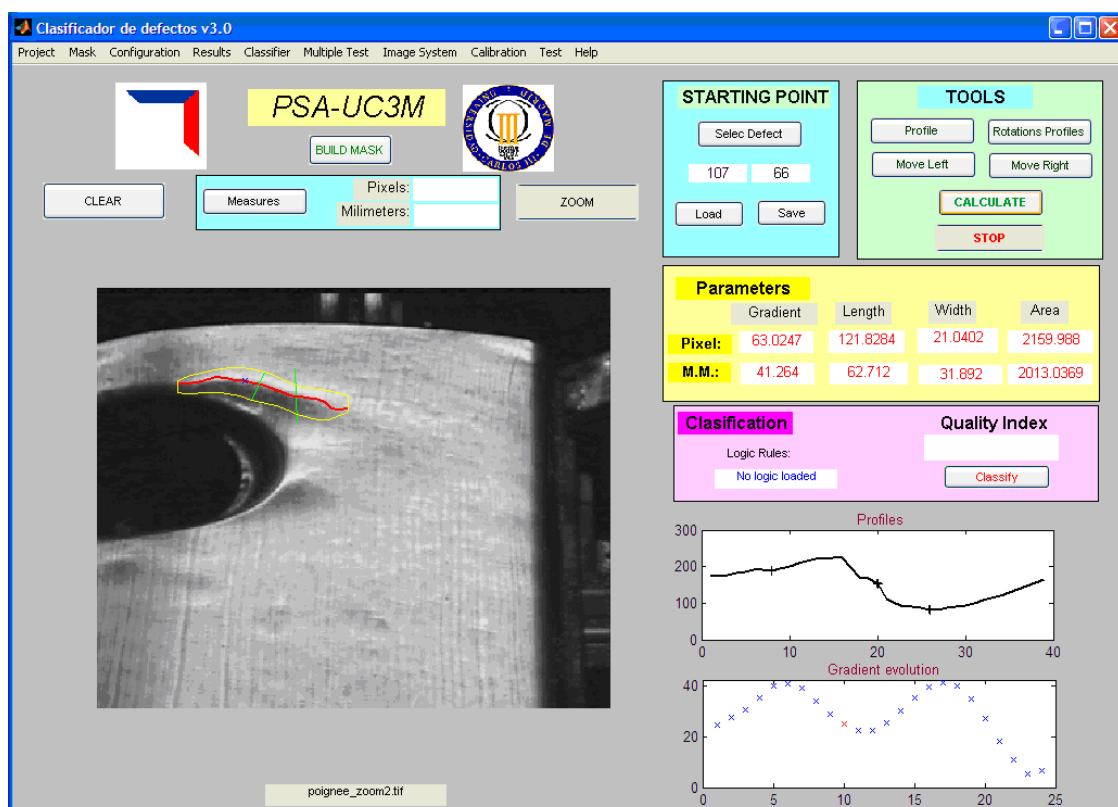
Figure 9. Graphical and numerical results obtained from the